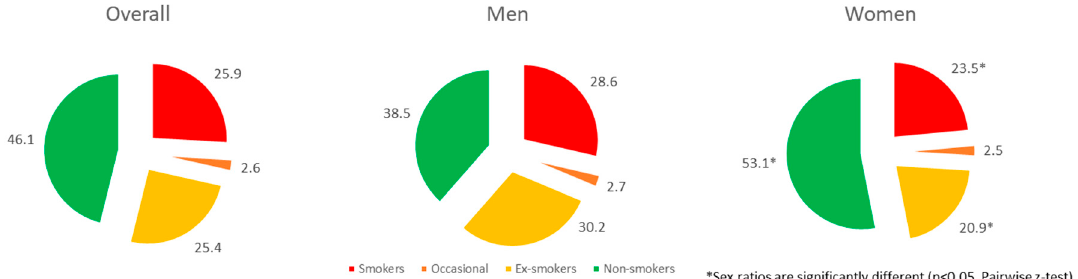
Figure A1. Smoking status in the general Spanish population and sex ratios.